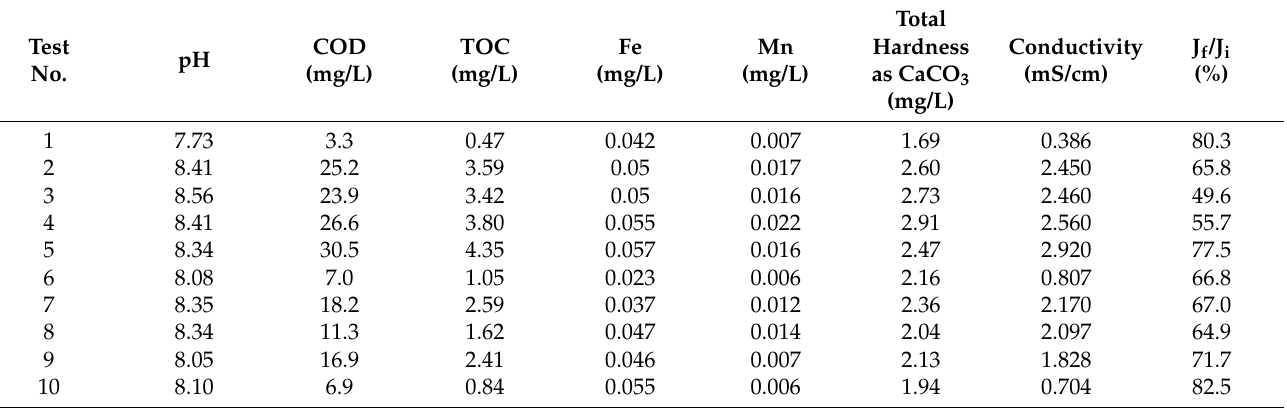
Table 9. Permeate quality and final flux of DuPont Filmtec BW RO membrane in the orthogonal (No. 1–9) and demonstration (No. 10)